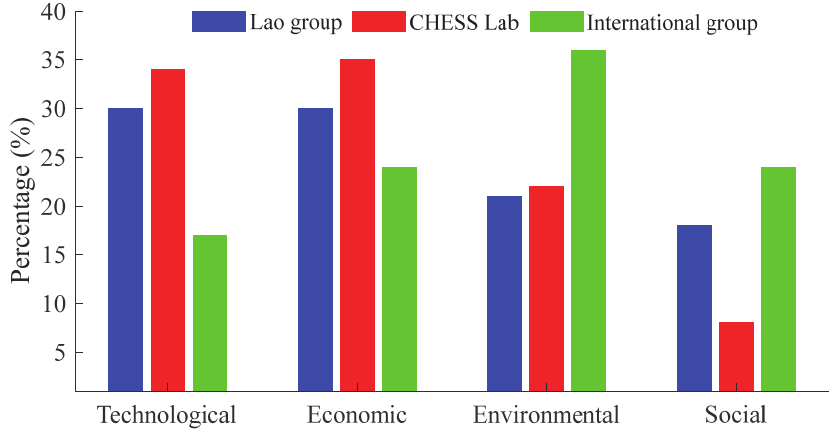
Figure 6. Relative weights of the main criteria of the three groups.